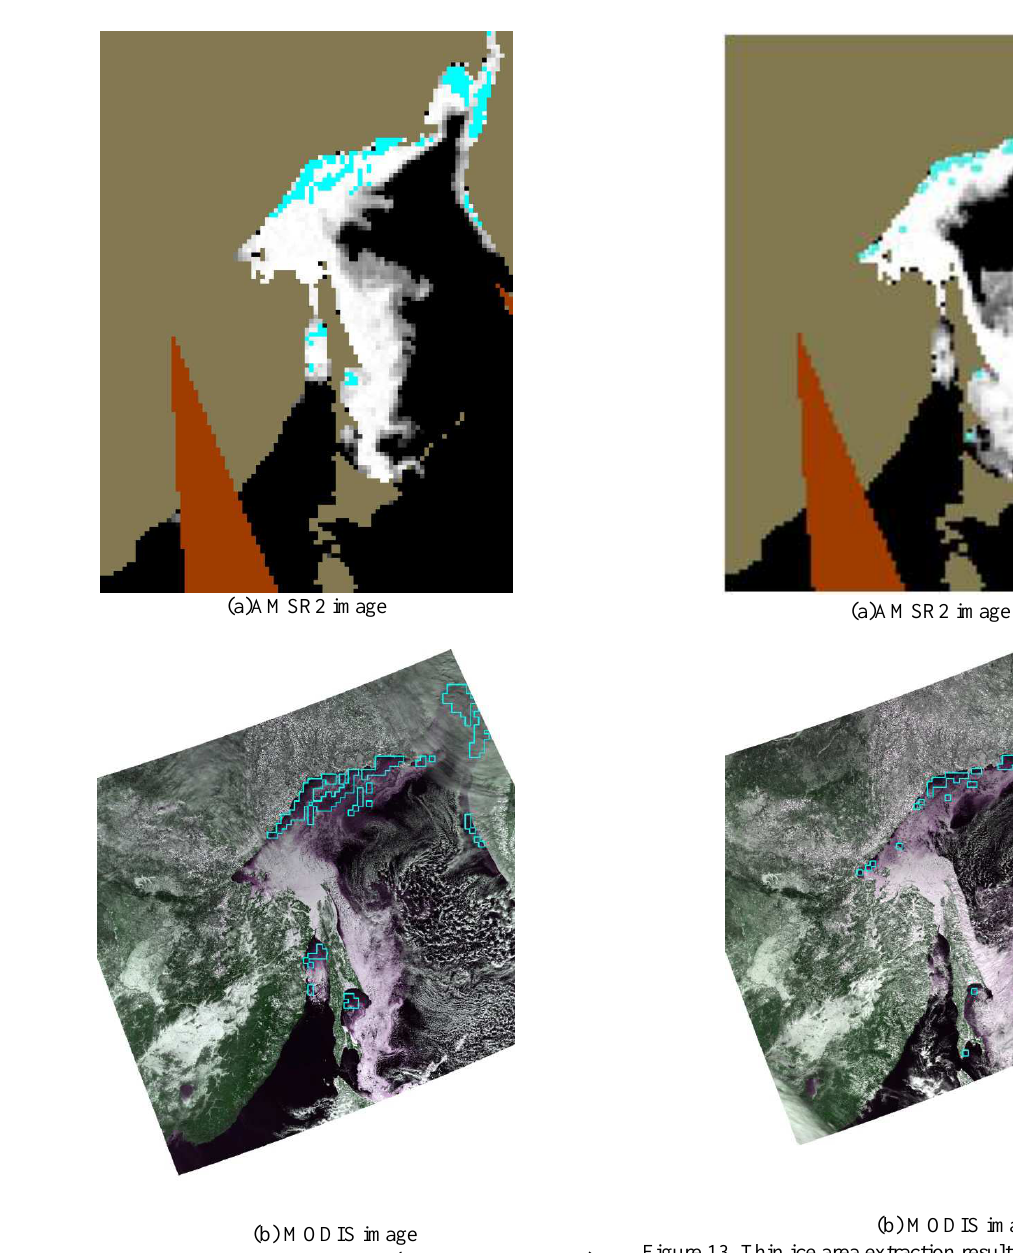
Figure 11. Thin ice area extraction result (Cyan: extracted area) (Sea of Okhotsk, February 23, 2014)